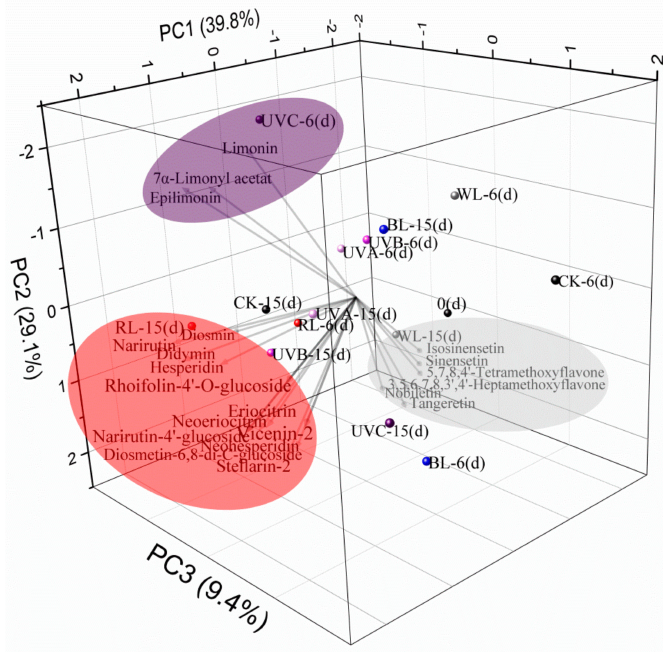
Figure 5. PCA model based on 21 phytochemicals in Newhall navel orange in response to di ff erent forms of light irradiation. DK: Dark; WL: White light; BL: Blue light; RL: Red light; UVA: Ultraviolet A; UVB: Ultraviolet B; UVC: Ultraviolet C; d: Days after